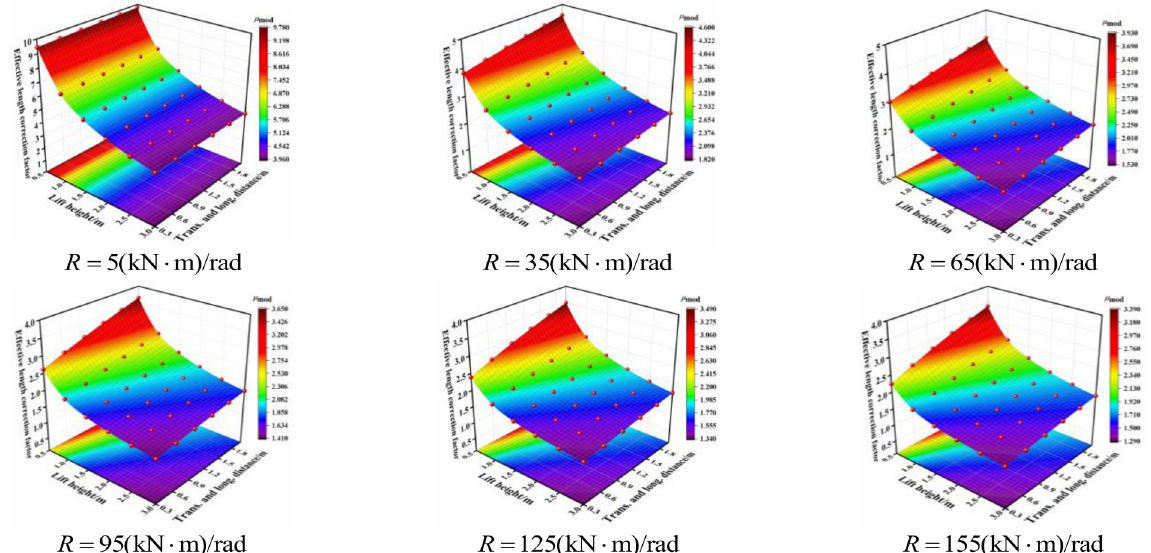
Fig 14. Three-dimensional cloud diagrams of the effective length correction factor under different joint bending stiffness of condition 1.